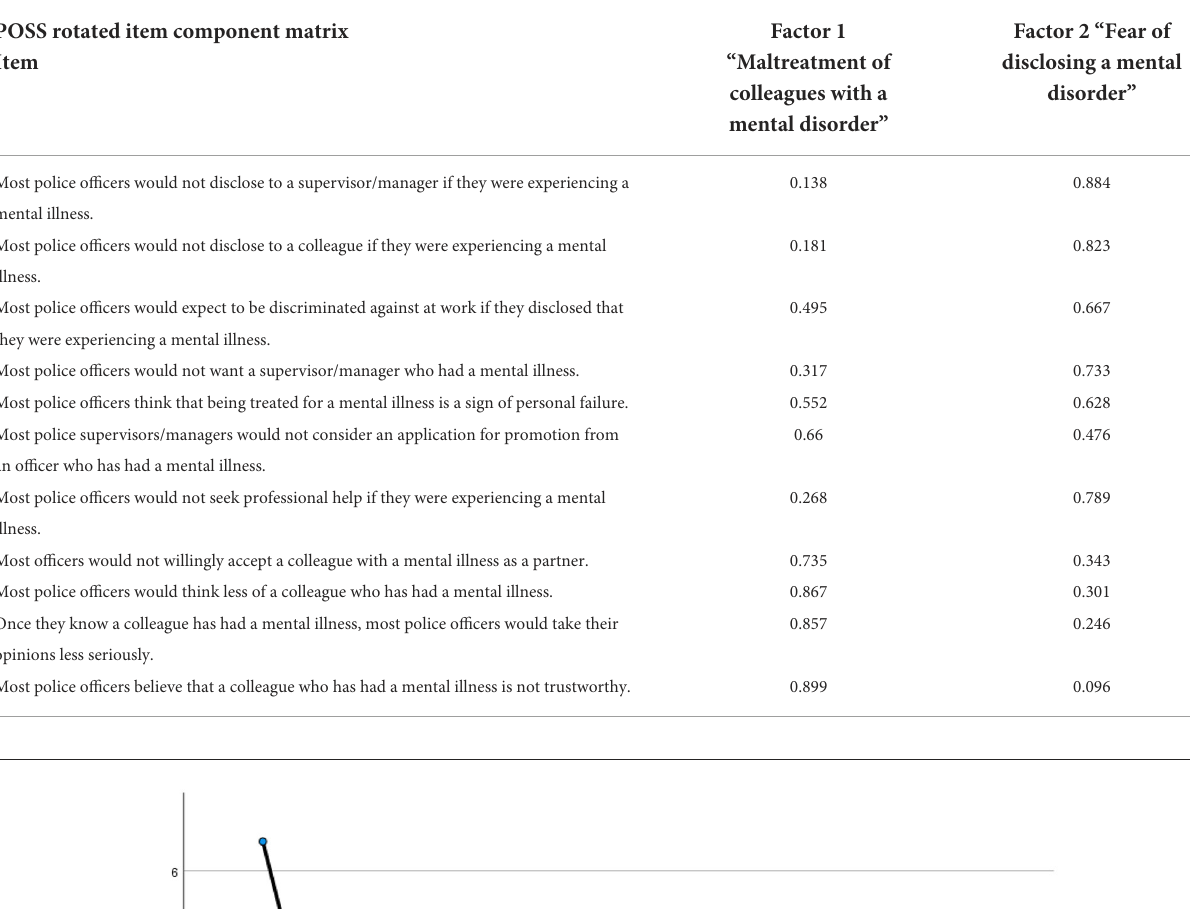
TABLE 2 Rotated factor loadings by item.